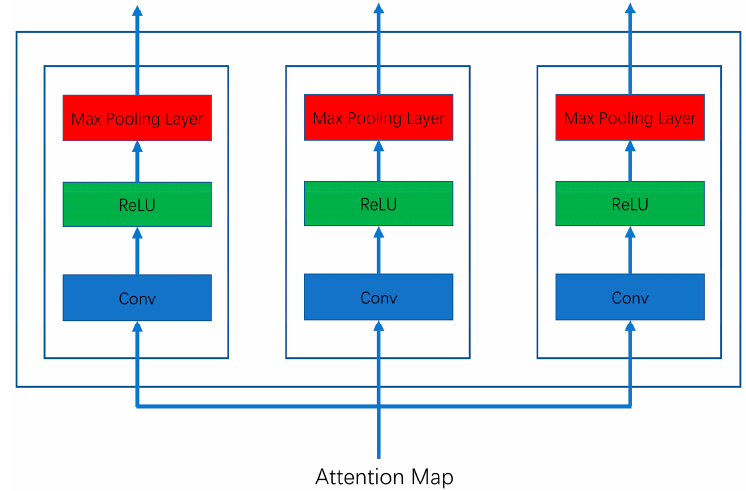
Figure 4. Network Structure of the Max Pooling Module.